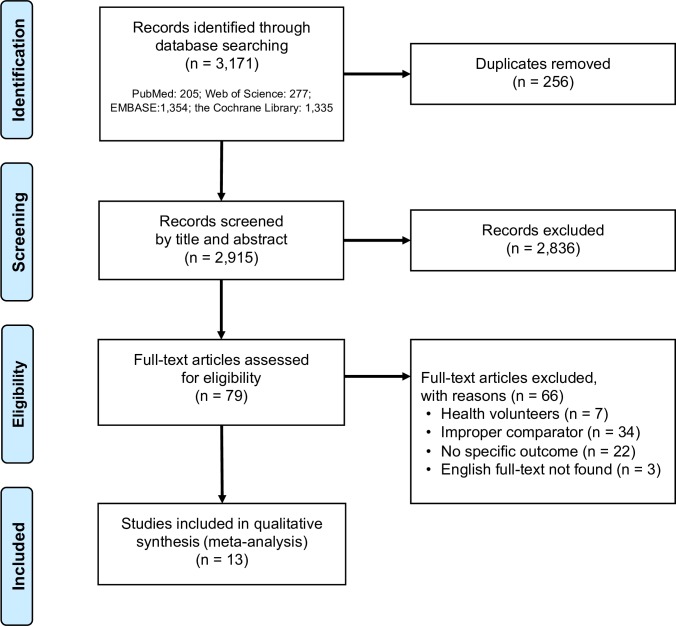
The flowchart of study enrollment.